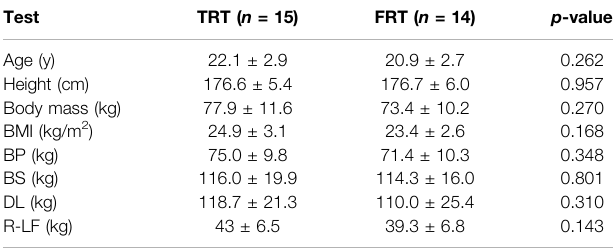
TABLE 2 | Anthropometric characteristics of the participants at